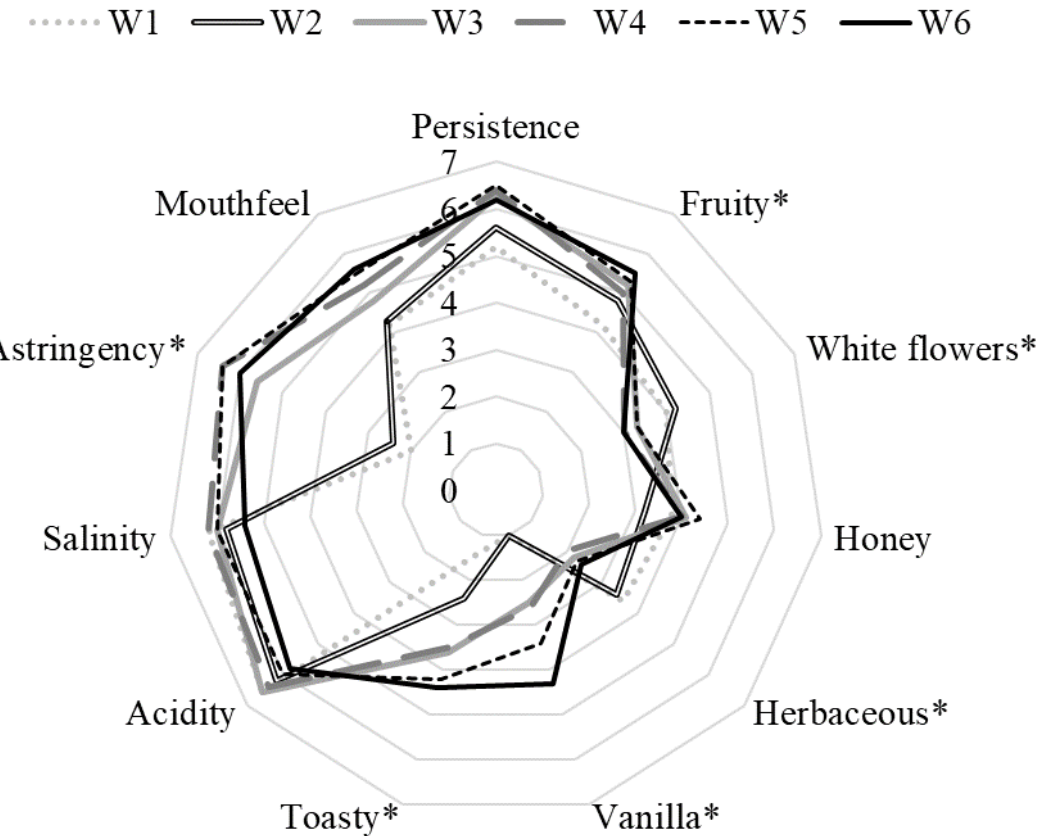
Figure 2. Sensory analysis of wines. * p <